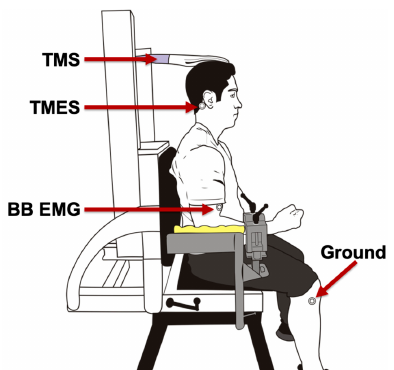
Figure 1. Participant’s experimental set-up. Participants were positioned up right in an elevated chair with shoulders at 0 degrees and elbows at 90 degrees. TMS: transcranial magnetic stimulation, TMES: transmastoid electrical stimulation, BB EMG: biceps brachii electromyography. Ground: ground electrode.